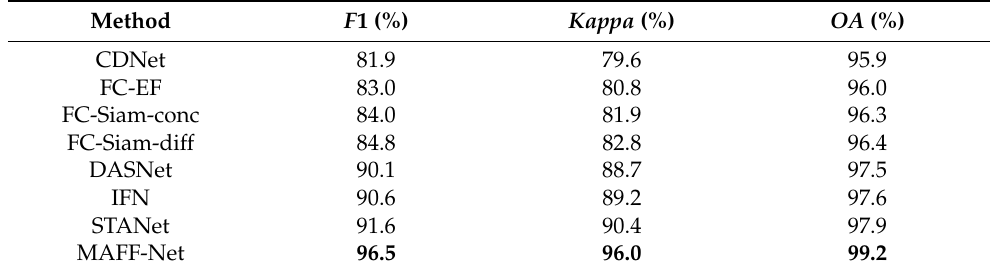
Table 2. Comparison of CDD dataset results. The best scores are highlighted in bold.